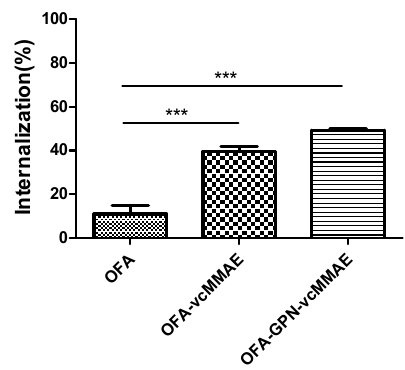
Figure 7. The percentages of internalization of OFA, OFA-vcMMAE and OFA-GPN-vcMMAE at 37 °C for 2 h. The p -value is indicated as follows: *** p <0.001, compared with unconjugated OFA group.